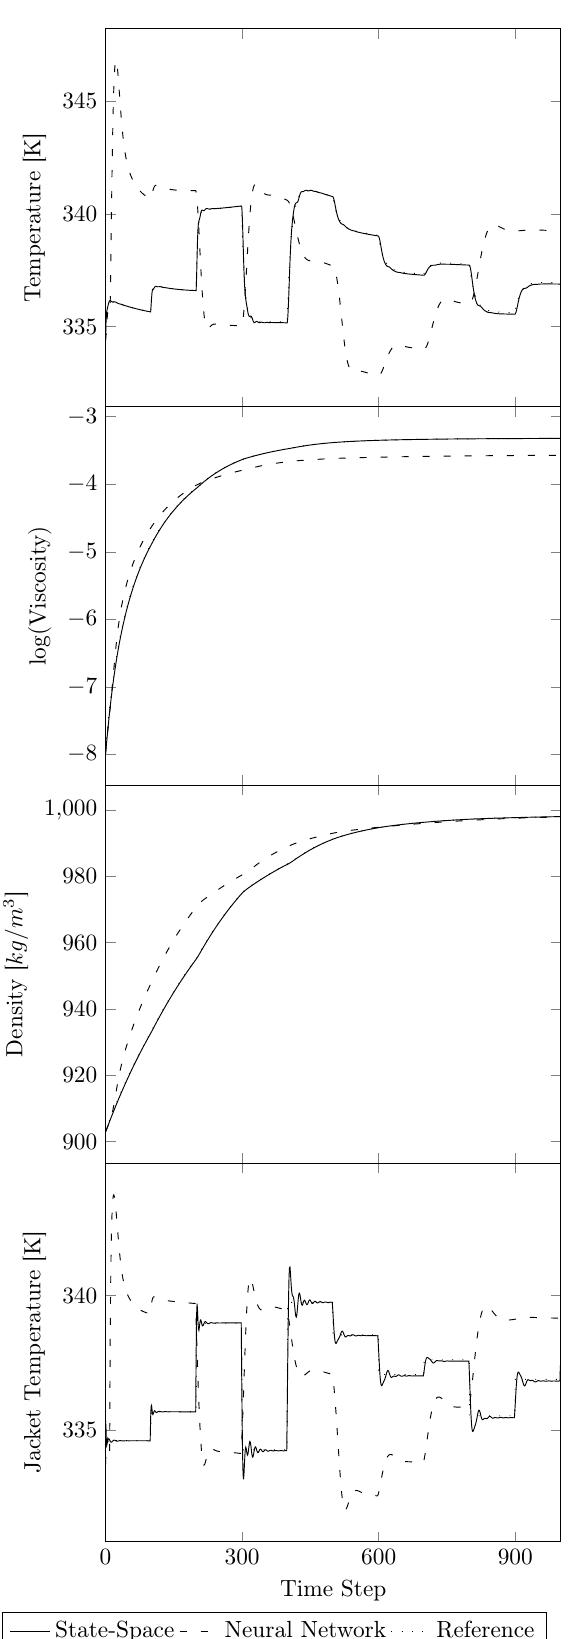
Figure 10. Implementation of state-space models and NARX networks into MPC in the absence of measurement noise and using newly generated reference